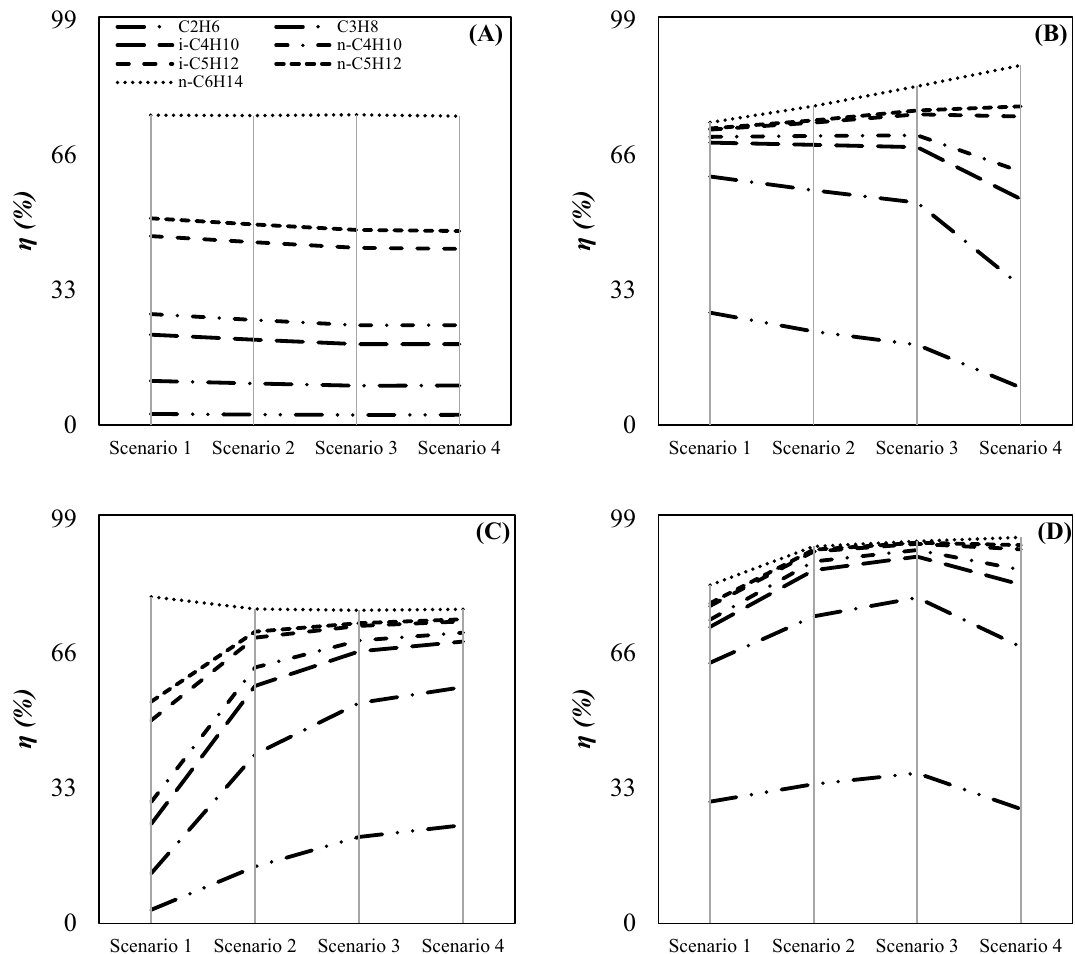
Figure 13. Component collection efficiency for various scenarios and configurations: ( A–D ) correspond to configurations ( A–D ) respectively with dp = 2